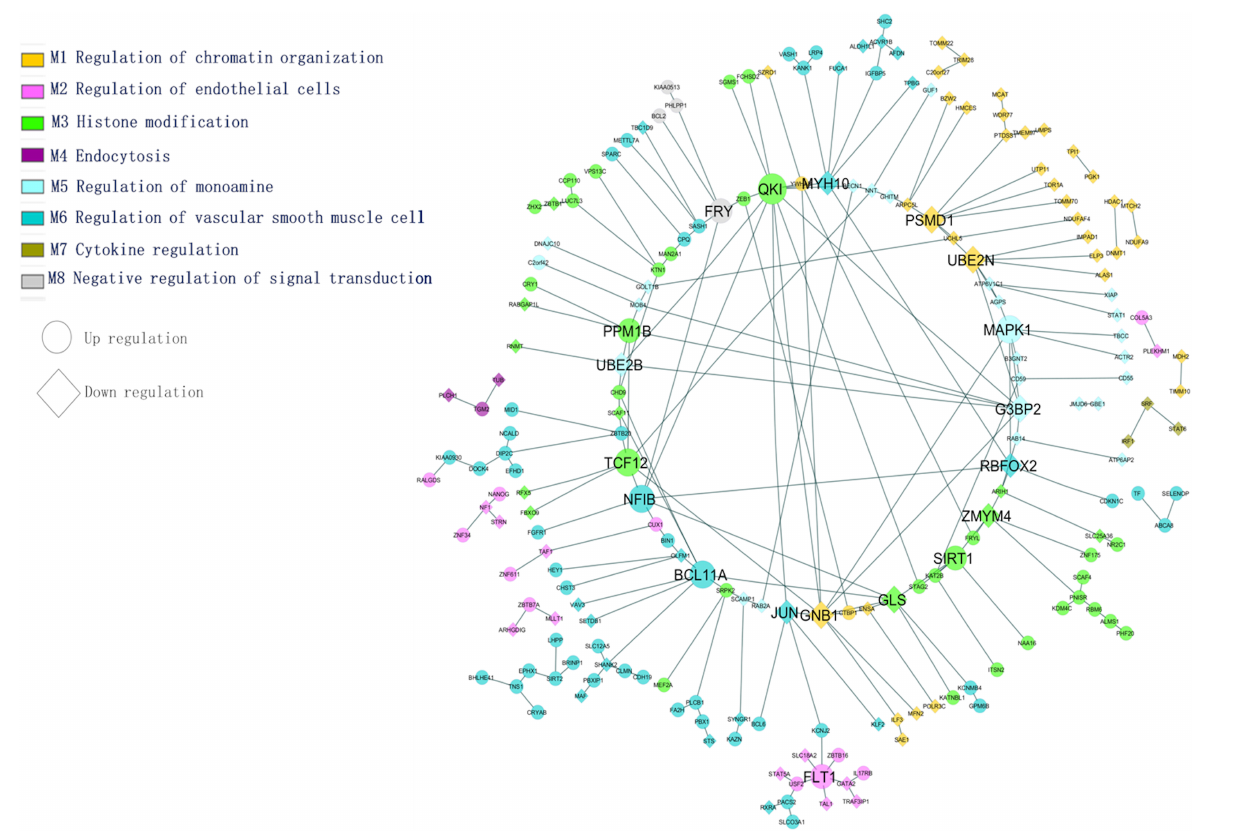
FIGURE 5 | Tissue-specific (BA9) enrichment functional module network (transcription factors and differentially expressed